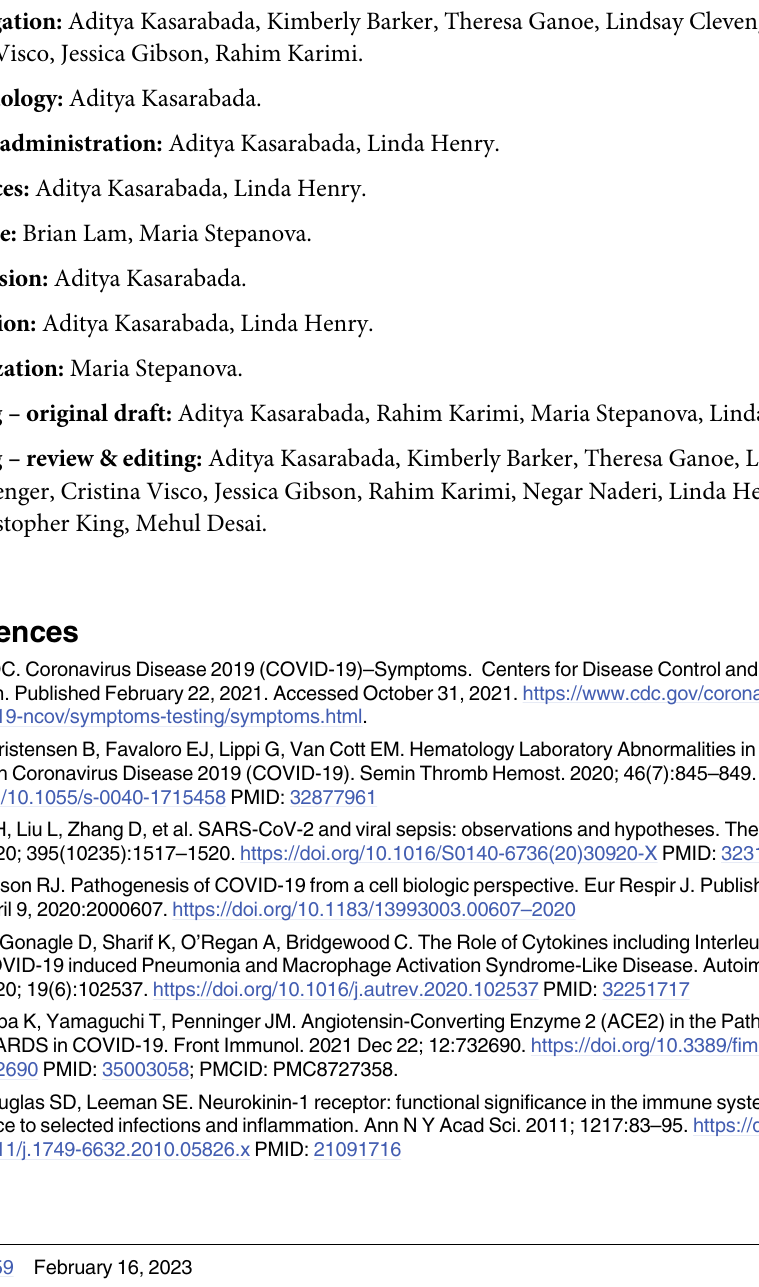
S2 Table. Comparison of patients by the number of days on high-flow oxygen before intu-